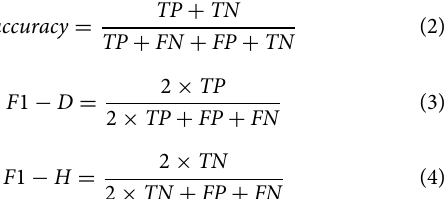
of multi-task ensemble learning methods with speaker